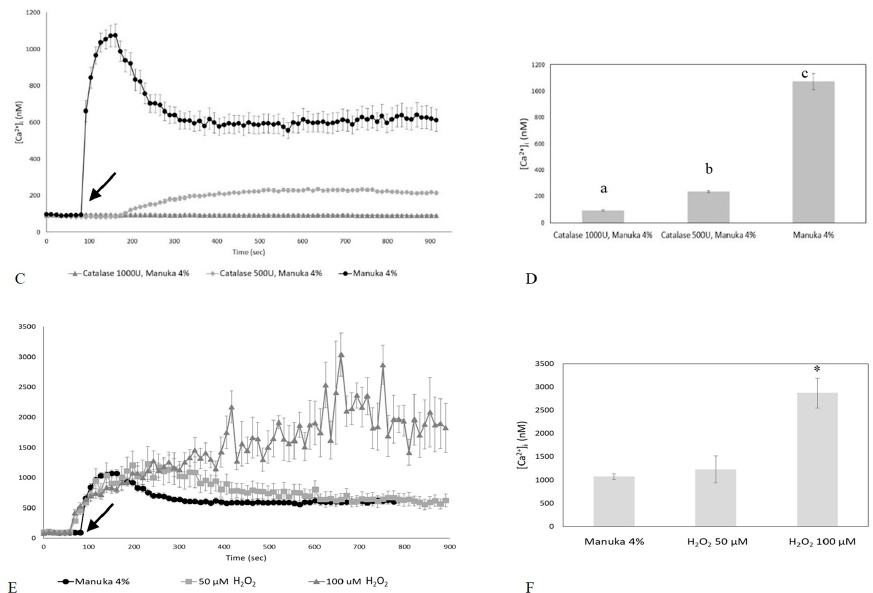
Figure 3. The Ca 2+ response to manuka honey requires the intracellular production of hydrogen peroxide. ( A ) Production of H 2 O 2 after 10 min incubation with increasing concentrations of distinct honey types. Different asterisks above bars indicate statistical difference determined One-way ANOVA followed by Bonferroni post-test ( p < 0.01); ( B ) Fluorescence values recorded at 10 min in control cells (ctrl), or in cells incubated with different honey samples (i.e., Acacia, Manuka, Buckwheat 4% v / v ) (* p < 0.001, Tukey’s test). Data are presented as means ± SD of rhodamine 123 fluorescence expressed in arbitrary units; n = 16 microplate wells from two different experiments. ( C ) The Ca 2+ response to 4% v / v manuka honey is inhibited by Catalase (CAT, 30 min preincubation) in a dose-dependent manner. Data are presented as means ± SEM of [Ca 2+ ] i traces recorded in different cells. The arrow indicates the addition of manuka honey after 60 s. Number of cells: manuka honey: 40 cells from 3 exp; manuka honey + 500 U CAT: 40 cells from 3 exp; manuka honey + 1000 U CAT: 40 cells from 3 exp. ( D ) Mean ± SEM of the peak Ca 2+ response recorded under the designated treatments. Number of cells as in A . Different letters above the bars indicate statistical difference determined by One-way ANOVA followed by Bonferroni post-test ( p < 0.01). ( E ) [Ca 2+ ] i variations induced by 4% v / v manuka honey and by 50 and 100 µ M H 2 O 2 . Data are presented as means ± SEM of [Ca 2+ ] i traces recorded in different cells. The arrow indicates the addition of different treatments after 60 s. Number of cells: manuka honey: 40 cells from 3 exp; 50 µ M H 2 O 2 : 30 cells from 3 exp; 100 µ M H 2 O 2 : 30 cells from 3 exp. ( F ) Measurements of peak Ca 2+ response upon treatment with 4% v / v manuka honey or different H 2 O 2 concentrations. Mean ± SEM of the peak Ca 2+ response recorded under the designated